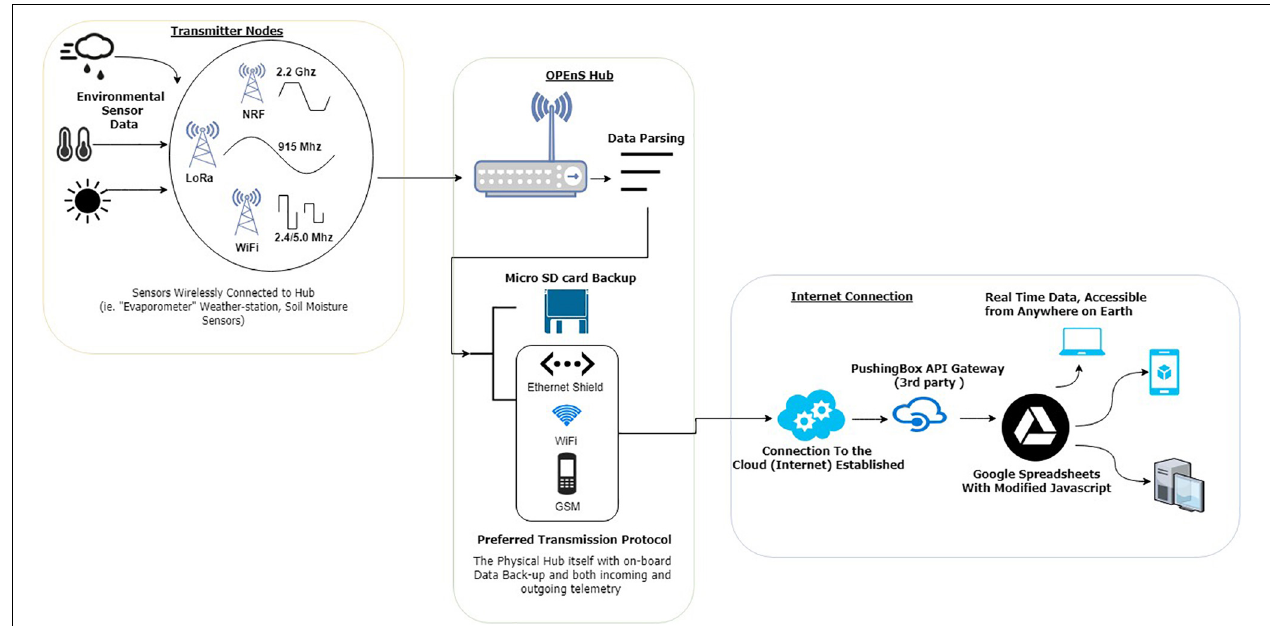
FIGURE 1 | The depiction above represents the data pipeline from the point of acquisition in the field to observation on personal devices.